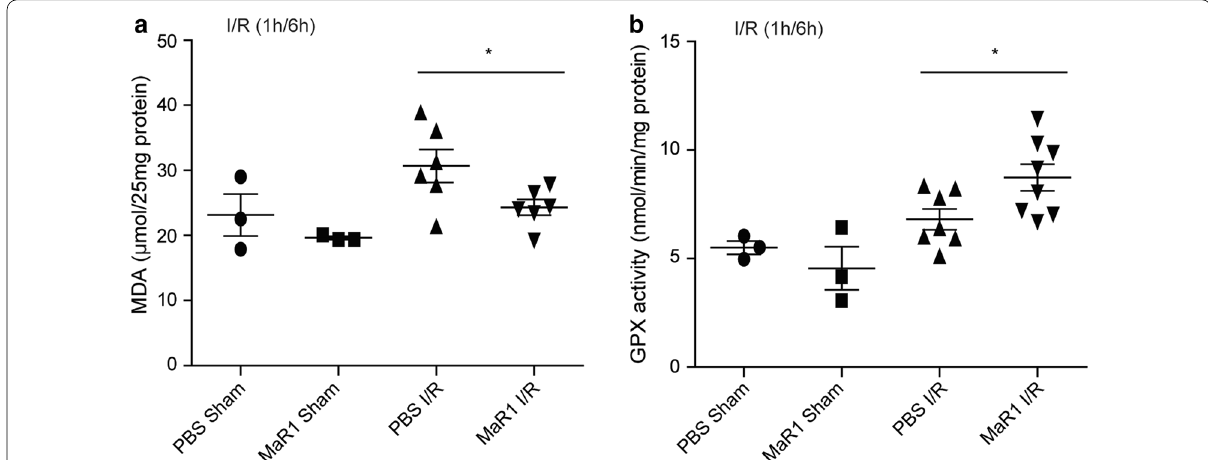
Fig. 4 MaR1 suppresses oxidativestress in the liver after I/R injury. Quantitativeanalysis of concentration of malondialdehyde (MDA) ( a ) and glutathione peroxidase (GPX) ( b ) in liver tissues of WT mice after sham surgery or liver I/R(1 h/6 h) treated with PBS or MaR1 (20 ng/mouse). Results are expressed as mean SEM. n 3 for sham groups; n 6-8 for I/R group. * P < 0.05 ± = =